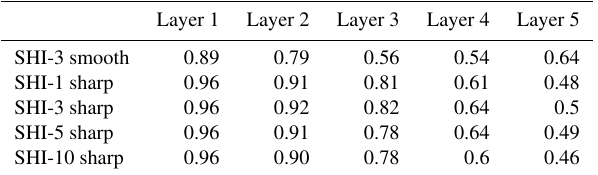
Table 1. Model structural accuracy comparison for the groundwater model using both smooth or sharp geophysical models and different background noise levels. The results are averaged over the 20 sys- tem realizations. A value of 1.0 means that the model’s hydraulic conductivity field is in good agreement with the reference field; a value of 0.0 means no agreement (see the body text for an exact definition of “structural